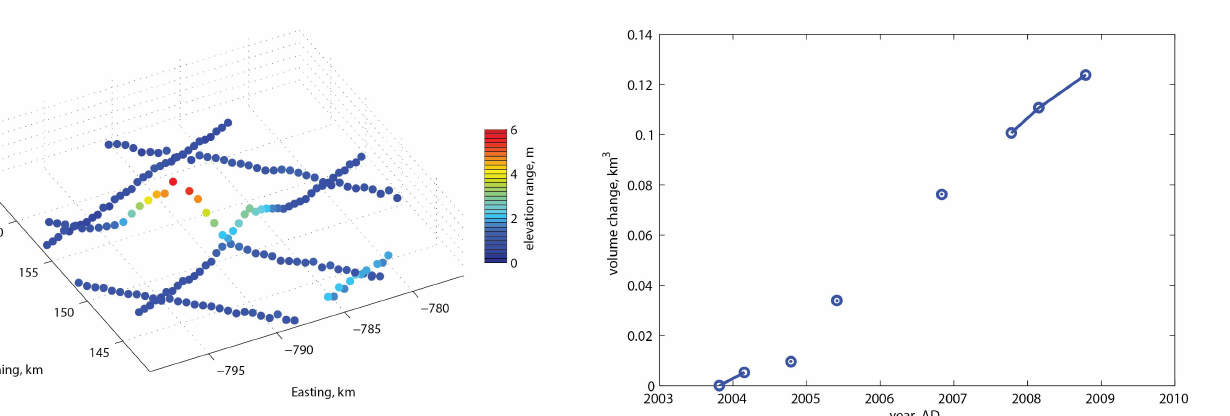
Fig. 3. Time-dependent change in the volume of Institute E2, us- ing the method detailed in Smith et al. (2009) and ICESat surface elevation data between 2003 and 2009. Note that the data points are connected when intervening campaigns gave valid volume esti- mates. The data point at the end of 2008 is new to this paper (others being available in Smith et al.,